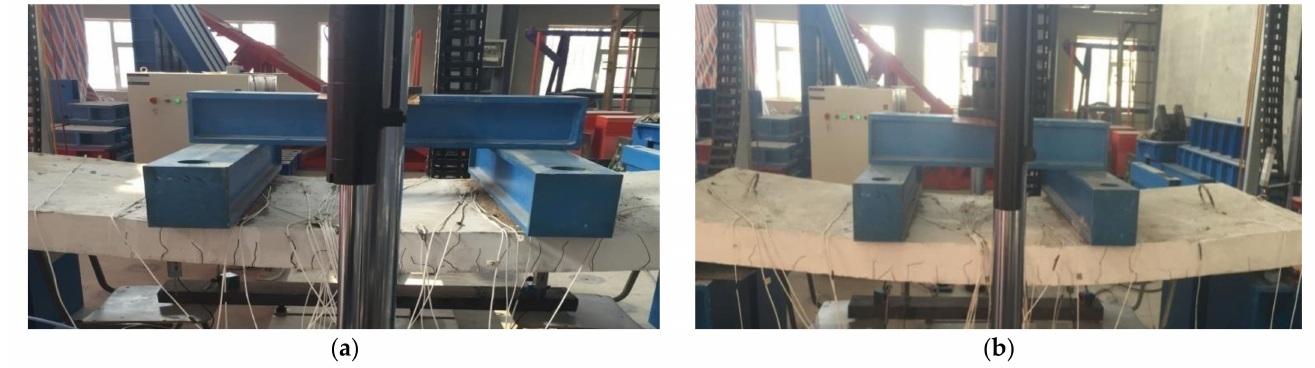
Figure 6. The crack distributions of some stages of the tests. ( a ) Vertical cracks of B-1; ( b ) Vertical cracks of B-2.